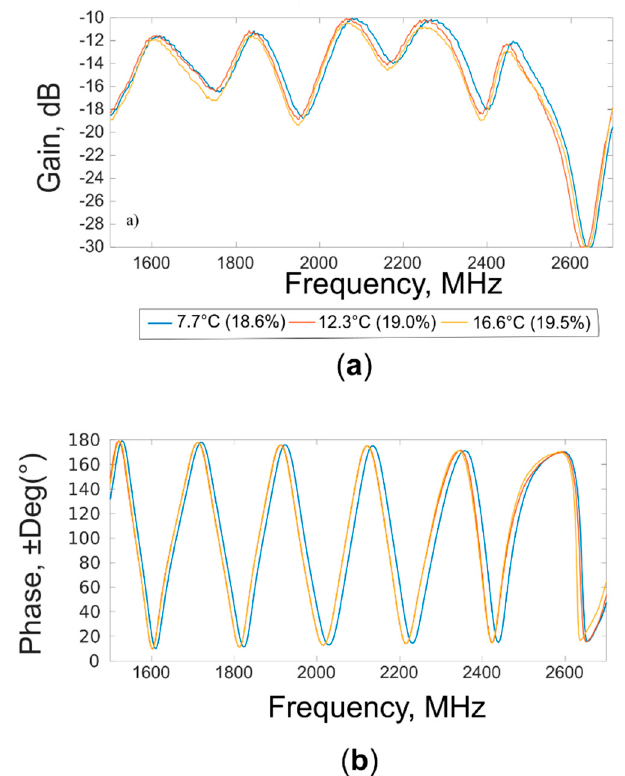
Figure 8. ( a ) “Gain” and ( b ) “phase” waveforms acquired at different soil temperatures (°C), at moisture of about 19.0%.